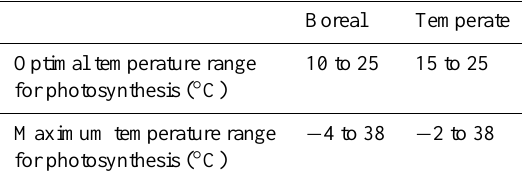
Table D9. Climatic range parameters. The affiliations to species are shown in Table